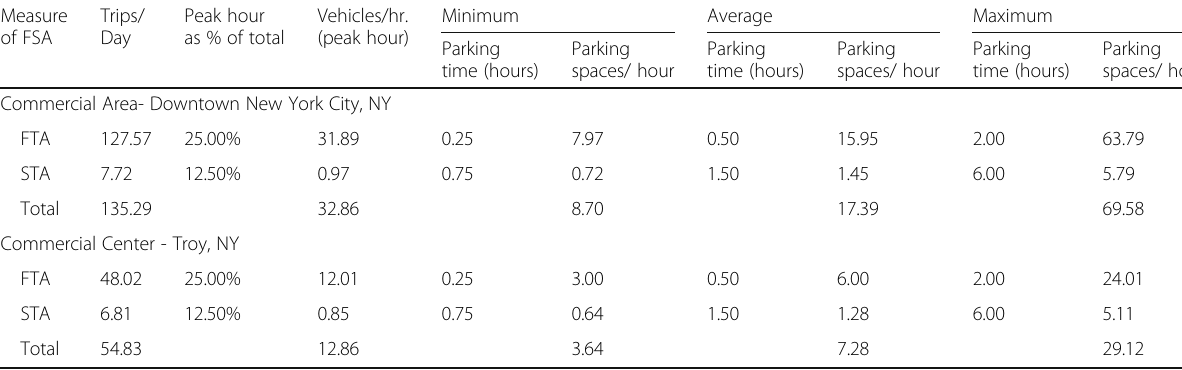
Table 1 Total freight and service vehicle parking needs Measure of